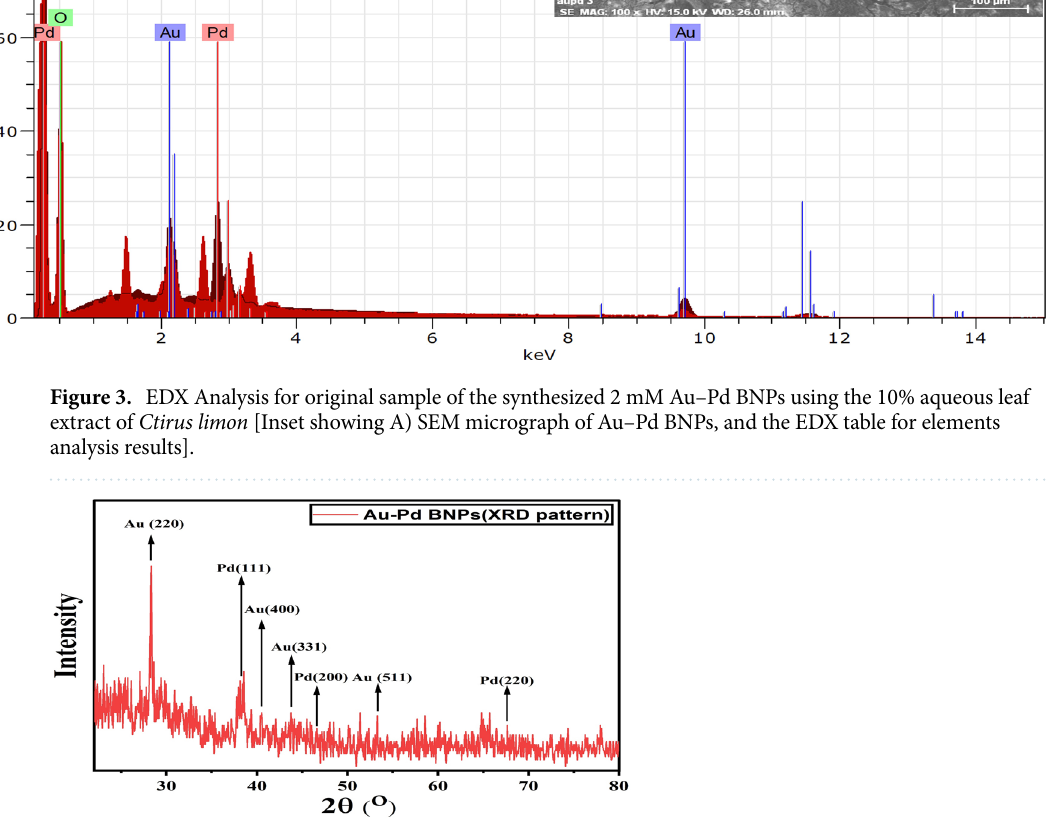
Figure 4. XRD pattern generated for the original sample of the 2 mM Au–Pd BNPs using 10% aqueous leaf extract of the plant Ctirus limon